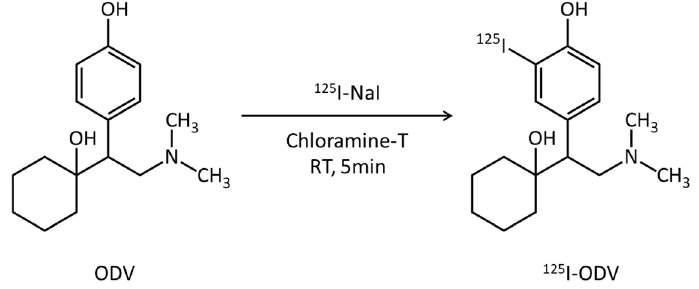
Figure 9. 125 I-labeling scheme of ODV. ODV was labeled with 125 I-NaI by oxidation reaction.